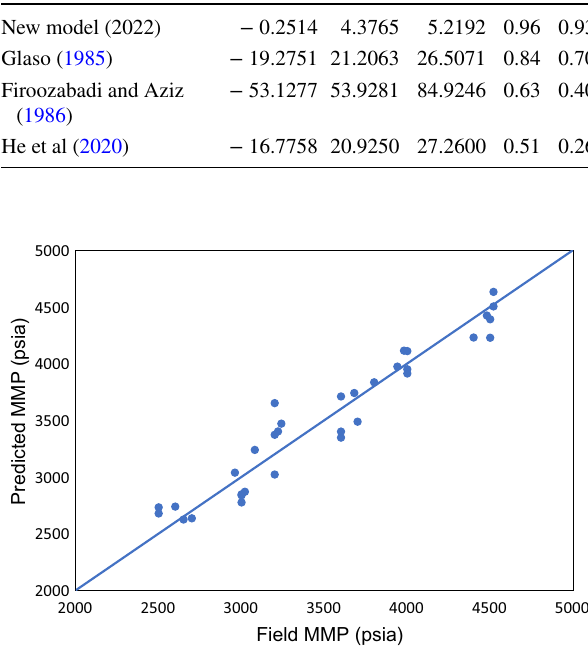
Fig. 3 Cross-plot of MMP training data for the new model